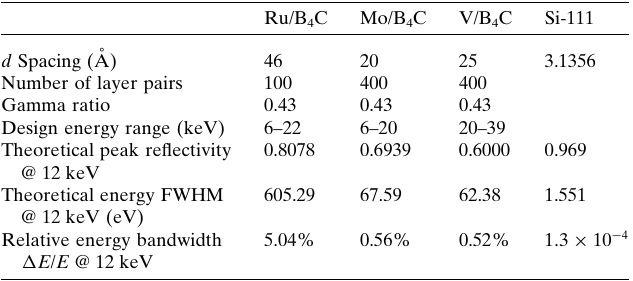
Table 1 Key parameters of the multilayer reflective coatings (for a single multilayer system) and the Si-111 reflection for comparison.